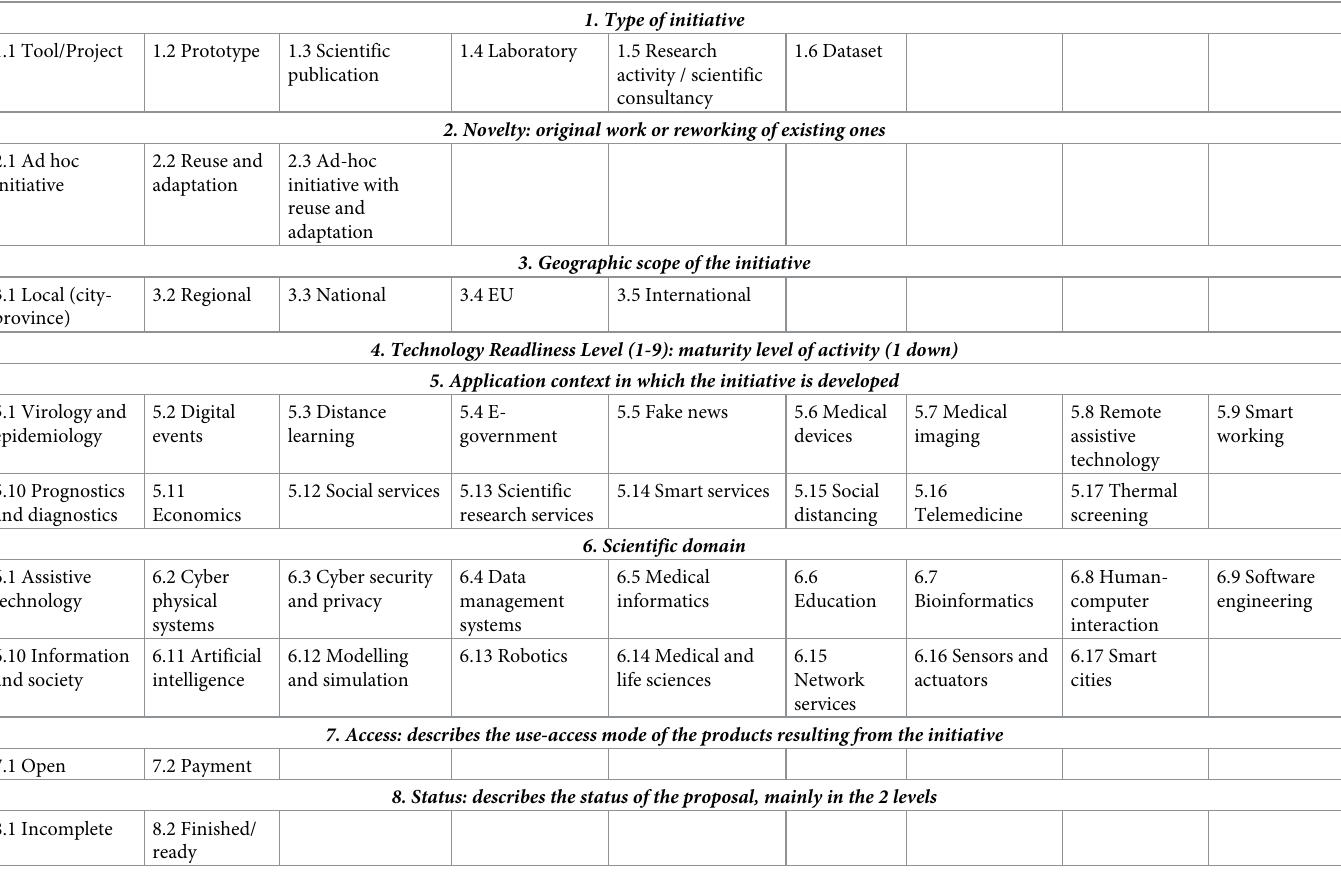
Table 2. Parameters required to the participants of the Covid19/IT